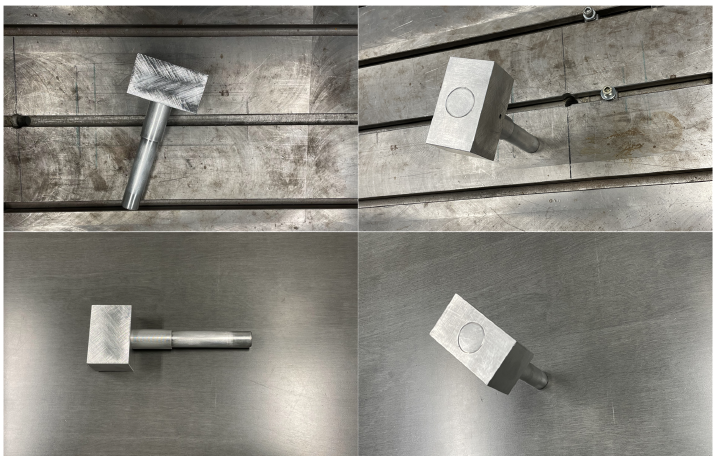
Figure 7. Experimental scenarios, including different backgrounds: wooden table and metal table, and different poses: standing pose and lying